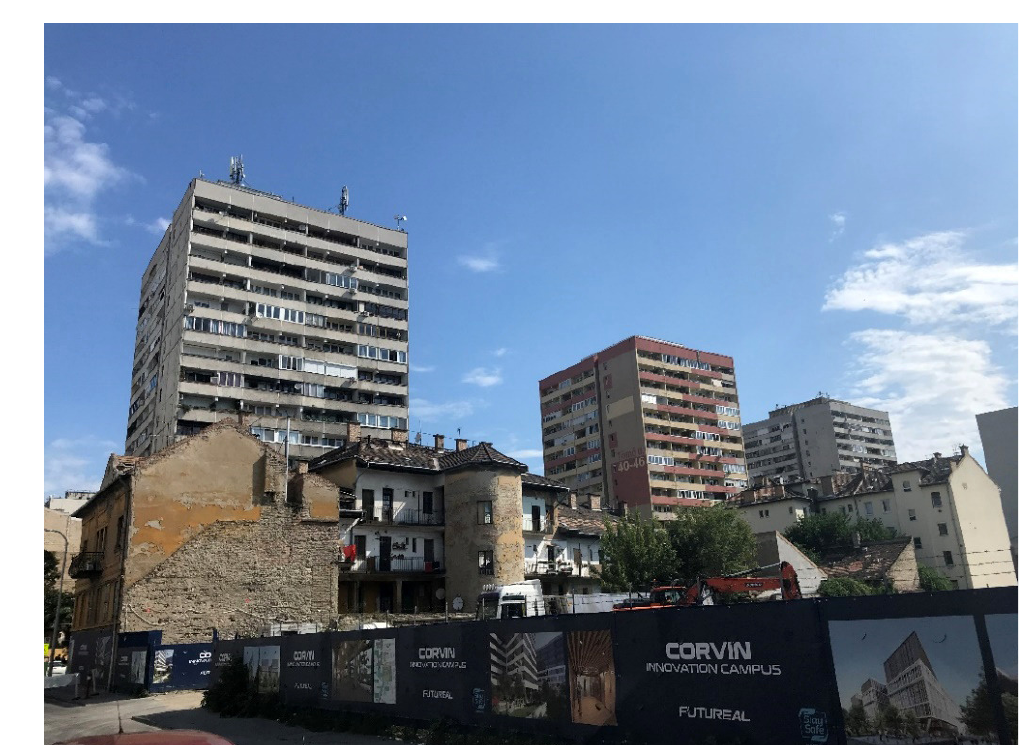
Figure 2. Budapest’s Szigony